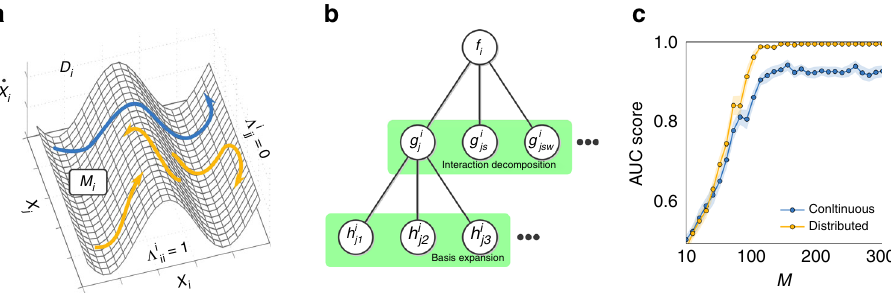
Fig. 1 Sampling dynamics spaces to reveal network structure. a Eq. (4) determines a mapping from state space components x to rates of change _ x i , de fi ning a smooth manifold M i (in dynamics space D i ) determined by f i and Λ i . b Two-stage decomposition of unknown functions f i , fi rst into interactions of different orders with other units in the network, second each interaction into basis functions, thereby resulting in a linear system (Eq. (6)) restricting the connectivity structure. c Quality of inferences versus the number M of measurements (displayed here for non-periodic dynamics of networks of phase- coupled oscillators of N = 20 and n i = 10 incoming connections per unit). “ Continuous sampling ” takes as observed dynamics one long trajectory of M sample time steps; “ distributed sampling ” takes M / m short time series of m = 10 sample time steps starting from different initial conditions, creating a longer time series of length M . The initial conditions were randomly drawn from uniform distributions de fi ned in the interval [ − π ,